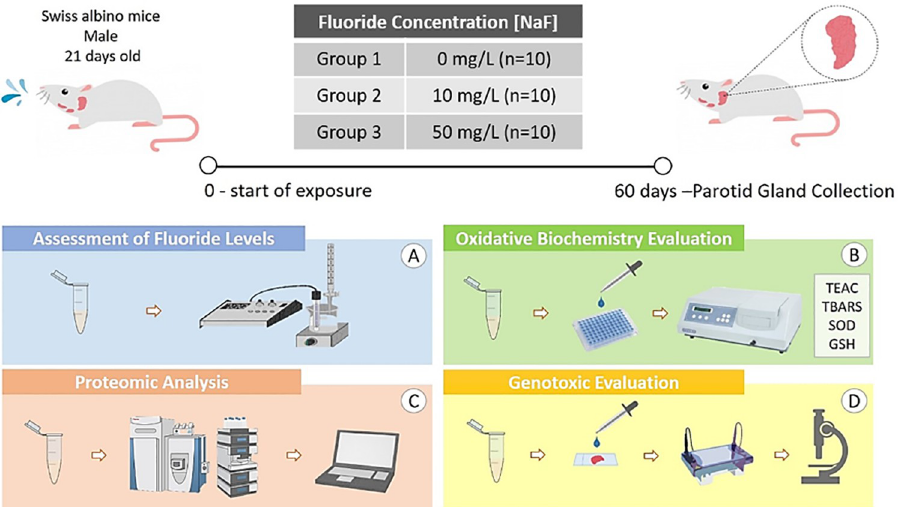
Fig 1. Methodological summary of the periods of experimentation, collection and analysis. 30 male Swiss albino mice (21 days old) received by voluntary consumption three fluoride (F) concentrations: 0 mg/L, 10 mg/L and 50 mg/L in deionized water (n = 10 per group). After 60 days of exposure, the animals were euthanized and the pair of parotid glands was collected for the following analyses: quantification of F concentration present in the glandular tissue (A); oxidative biochemistry (B), from Trolox Equivalent Antioxidant Capacity (TEAC), Thiobarbituric Acid Reactive Substances (TBARS), Superoxide Dismutase (SOD) and Reduced Glutathione (GSH) levels; analysis of protein expression profile (C), genotoxicity evaluation (D), based on the Comet Assay and histopathological analyses (F).